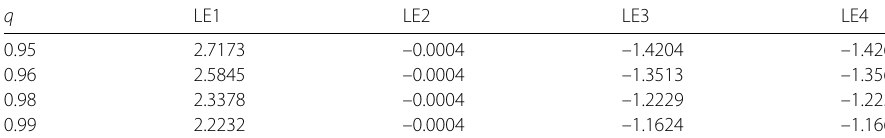
Figure 1 Bifurcation diagram for variation of the order q in the interval